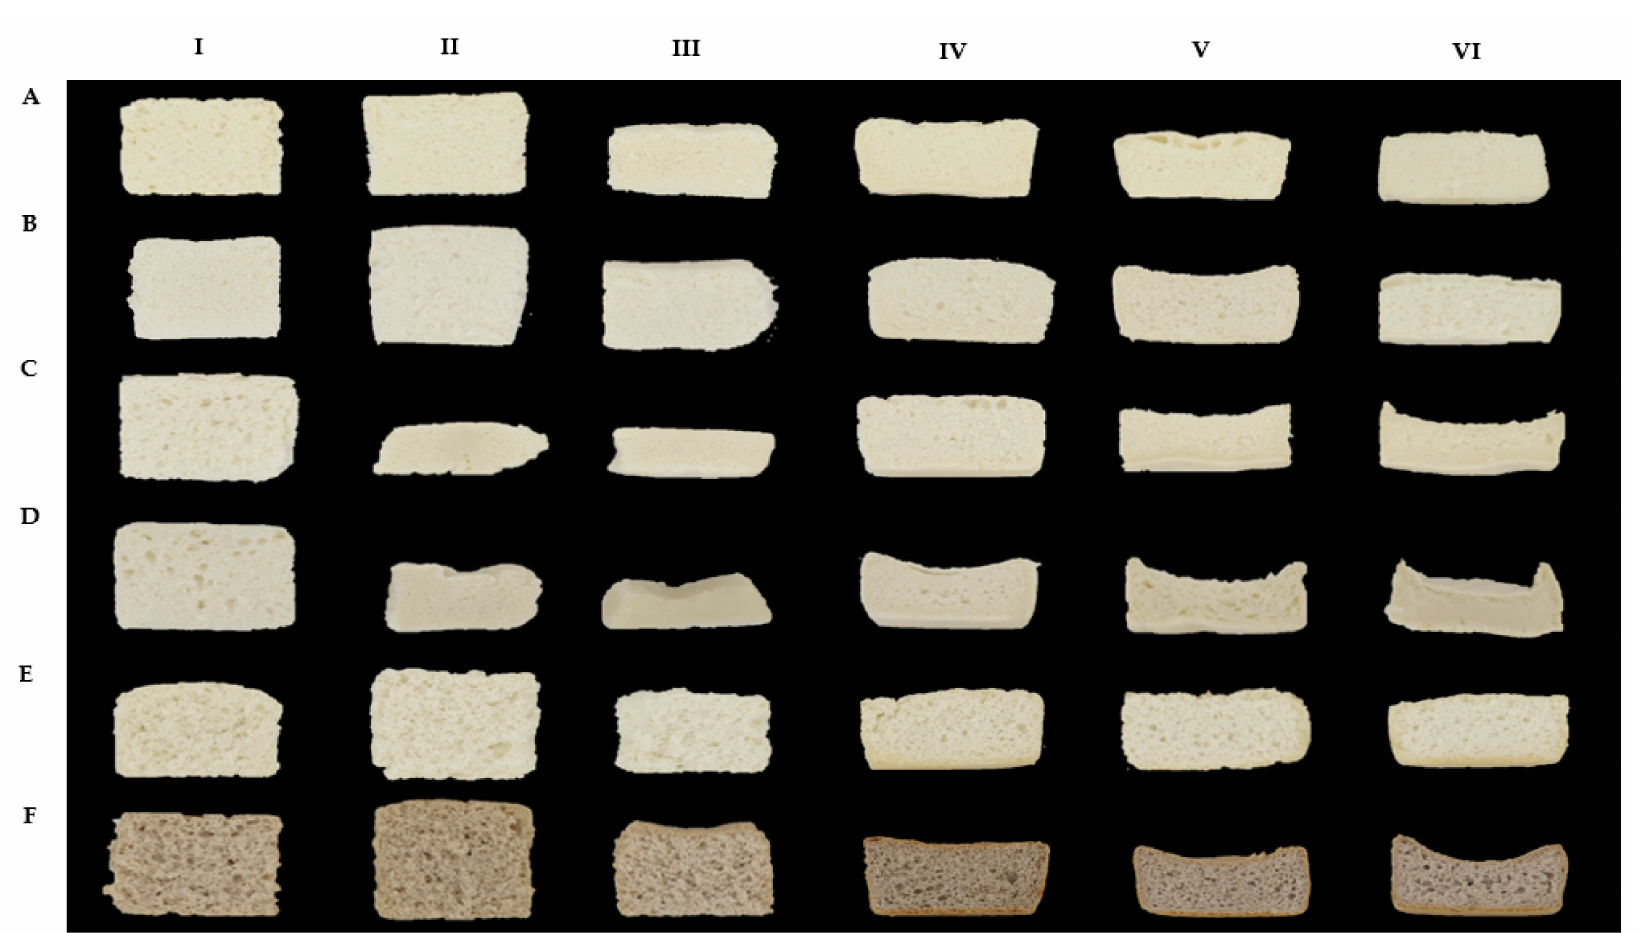
Figure 2. Cross-sections of GF bread slices from different starch or flour: ( A ) corn starch, ( B ) wheat starch, ( C ) potato starch, ( D ) cassava starch, ( E ) rice flour, and ( F ) buckwheat flour, and water ratio ( I ) OH 1:0.9, ( II ) OH 1:1.3, ( III ) OH 1:1.7, ( IV ) conventional 1:0.9, ( V ) conventional 1:1.3, and ( VI ) conventional 1:1.7. The water ratios for buckwheat flour were different, ( I ) OH 1:1, ( II ) OH 1:1.5, ( III ) OH 1:2, ( IV ) conventional 1:1, ( V ) conventional 1:1.5, and ( VI ) conventional